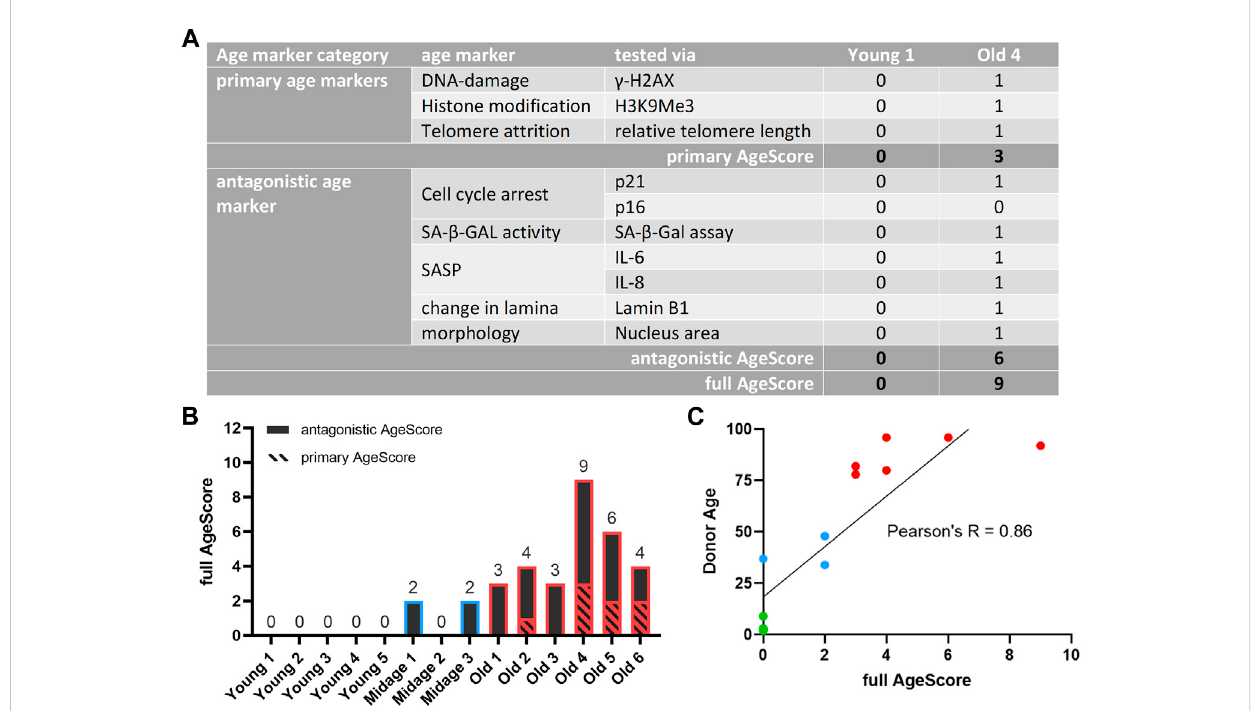
FIGURE 3 Calculated full AgeScore correlates with fi broblasts donor age. The here proposed full AgeScore (primary AgeScore + antagonistic AgeScore) correlates with donor age of examined human fi broblasts. (A) Calculation of proposed AgeScore for given examples (Young 1, Old 4). Each fi broblast tested receives a0 for anon-signi fi cant age marker and a1 for a signi fi cant age marker tested.These valuesare summed up to the primary AgeScore and theantagonisticAgeScore.ThesumofbothisthefullAgeScore. (B) CalculatedAgeScoreforexaminedhuman fi